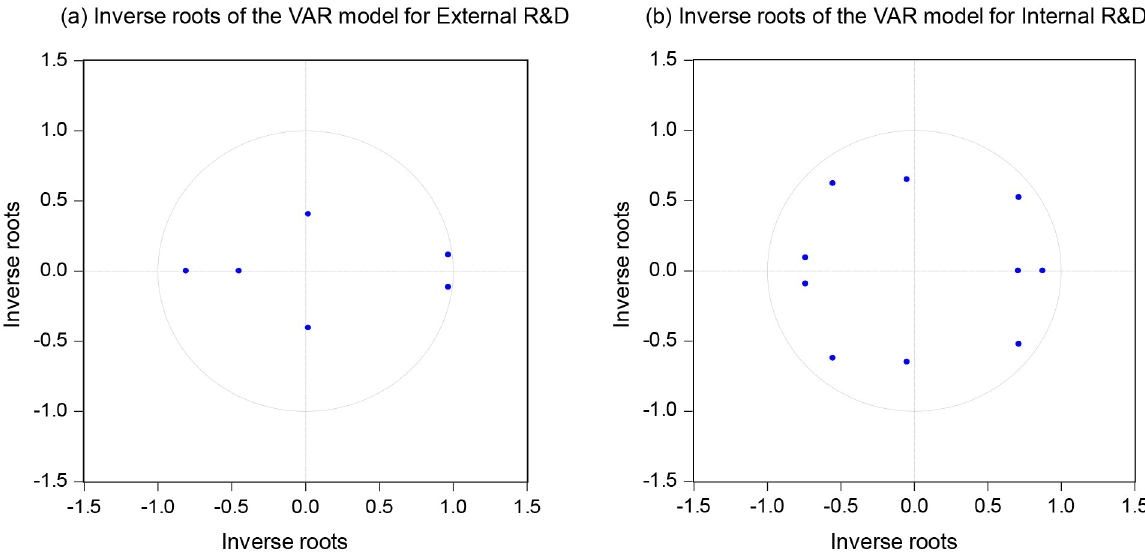
Fig 1. Stability tests for external and internal R&D VAR models.